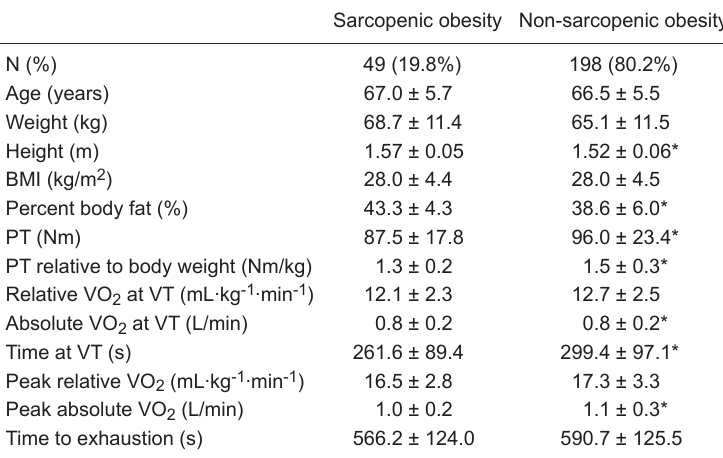
Table 2. Health-related physical fitness variables according to classification of sar- copenic obesity using the cutoff value proposed in the present